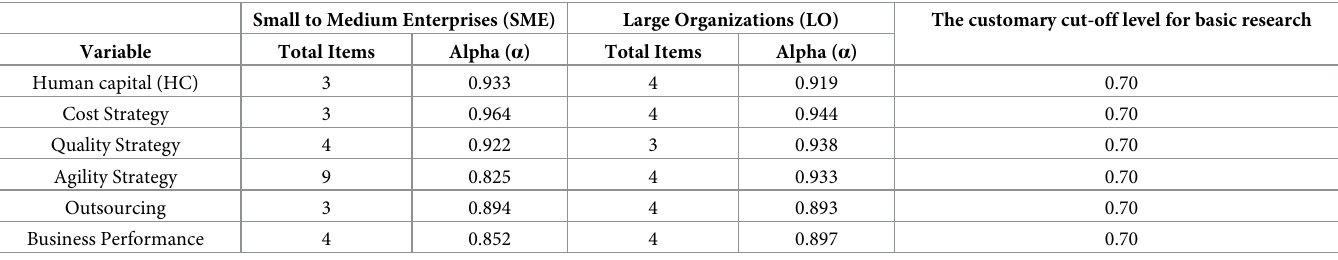
Table 3. Cronbach’s alpha for small–medium and large